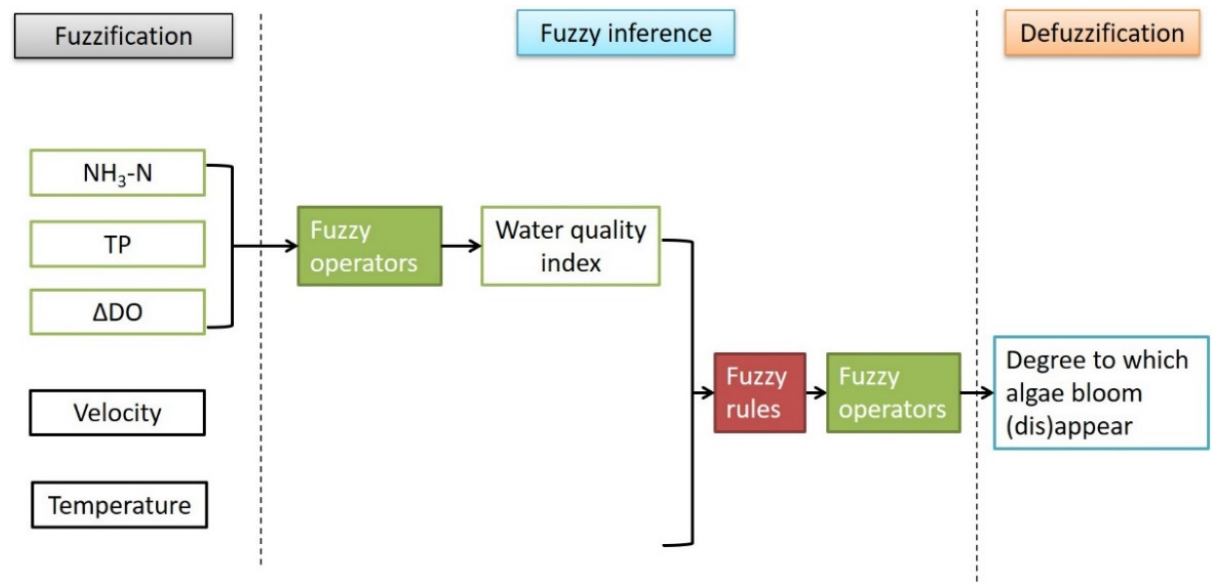
Figure 3. Schematic flow–diagram of the fuzzy model.